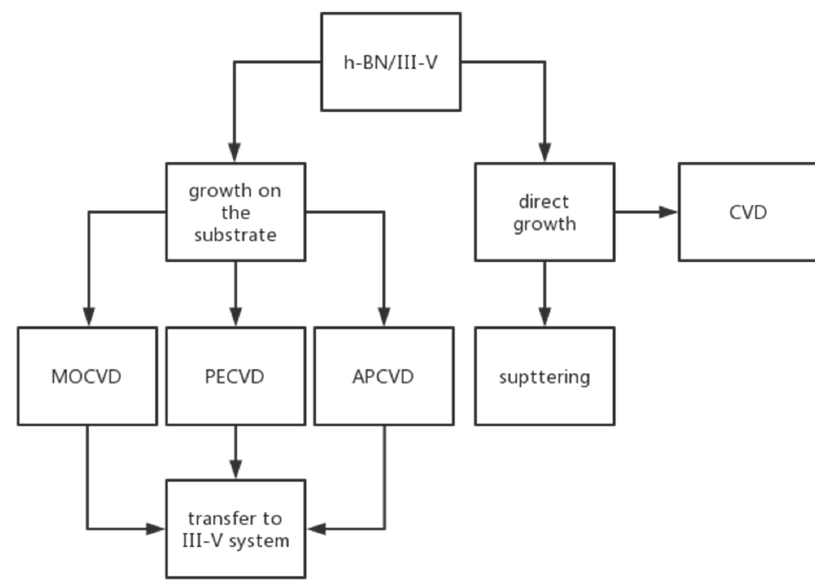
Figure 1. h-BN/III–V preparation methods.